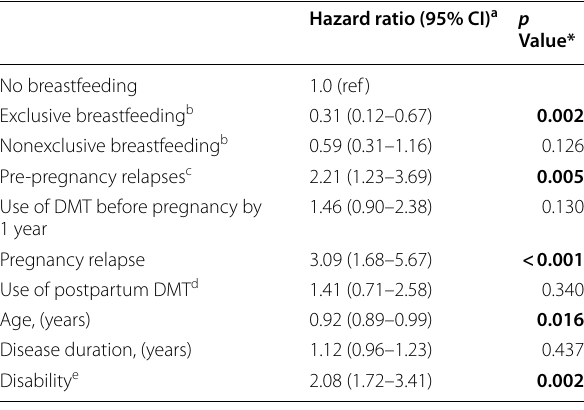
CI confidence interval; DMT disease-modifying therapy; MS multiple sclerosis a Cox proportional hazards model/ * Level of significance is set when the P-value <